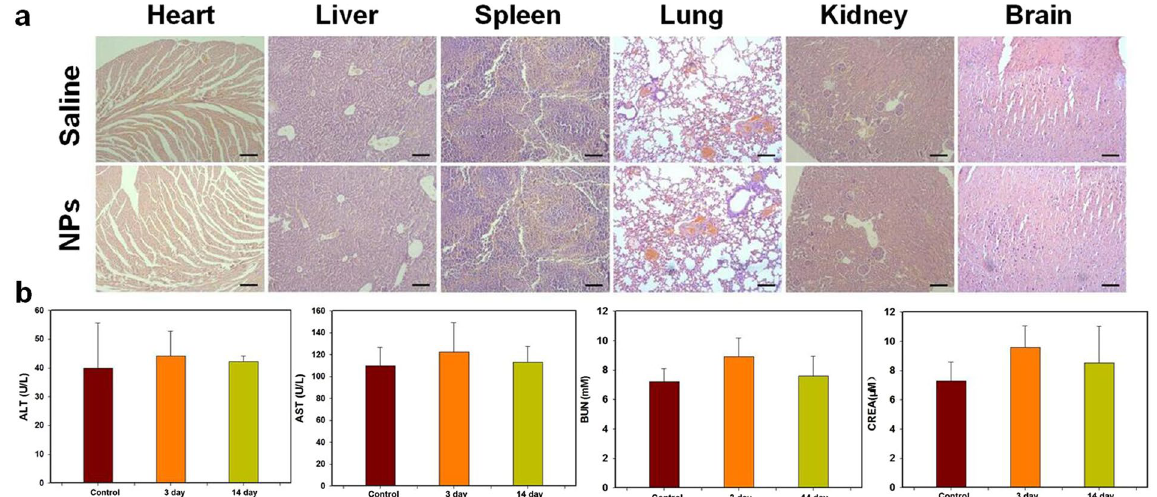
Figure 8. In vivo toxicity study. ( a ) H&E stained sections of major organs harvested 14 days after intravenous injection of 0.2 mL of 2 mg/mL Fe 3 O 4 /ICG@PLGA/PFP NPs or saline as the control. No noticeable abnormality was observed in the heart, liver, spleen, lung, kidney, or brain. ( b ) Levels of hepatic functional markers (ALT and AST) and renal functional markers (BUN and CREA) in the blood at 3 and 14 days after injection of Fe 3 O 4 / ICG@PLGA/PFP NPs or saline as the